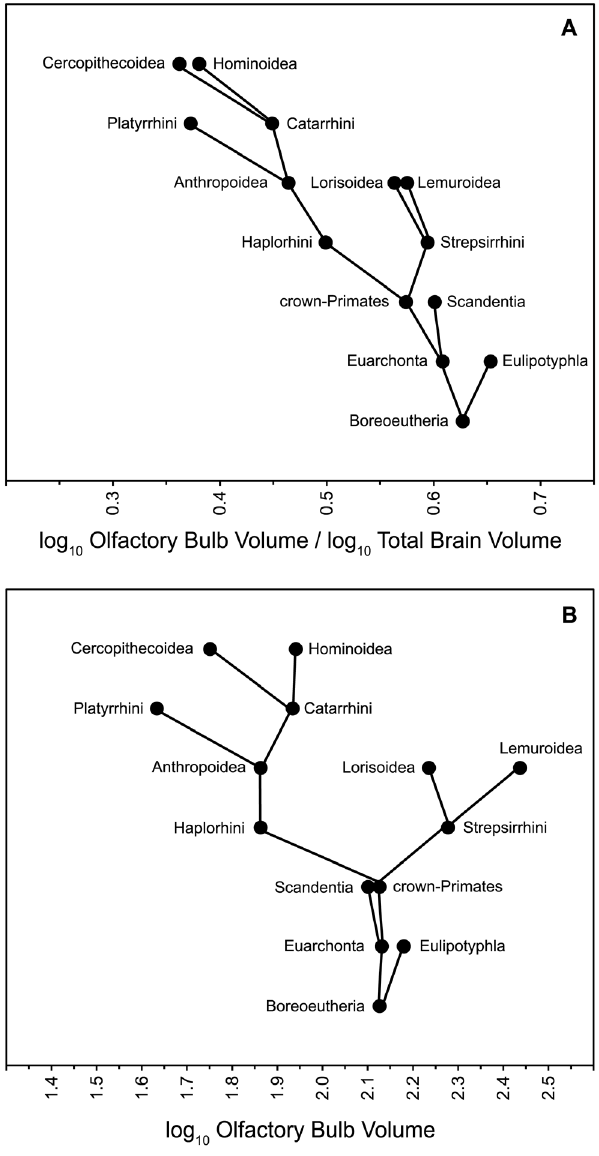
Figure 3. Paths of OB evolution. (A) OB change relative to TB volume. (B) Absolute OB change. Vertical axes depict clade nesting and are dimensionless.